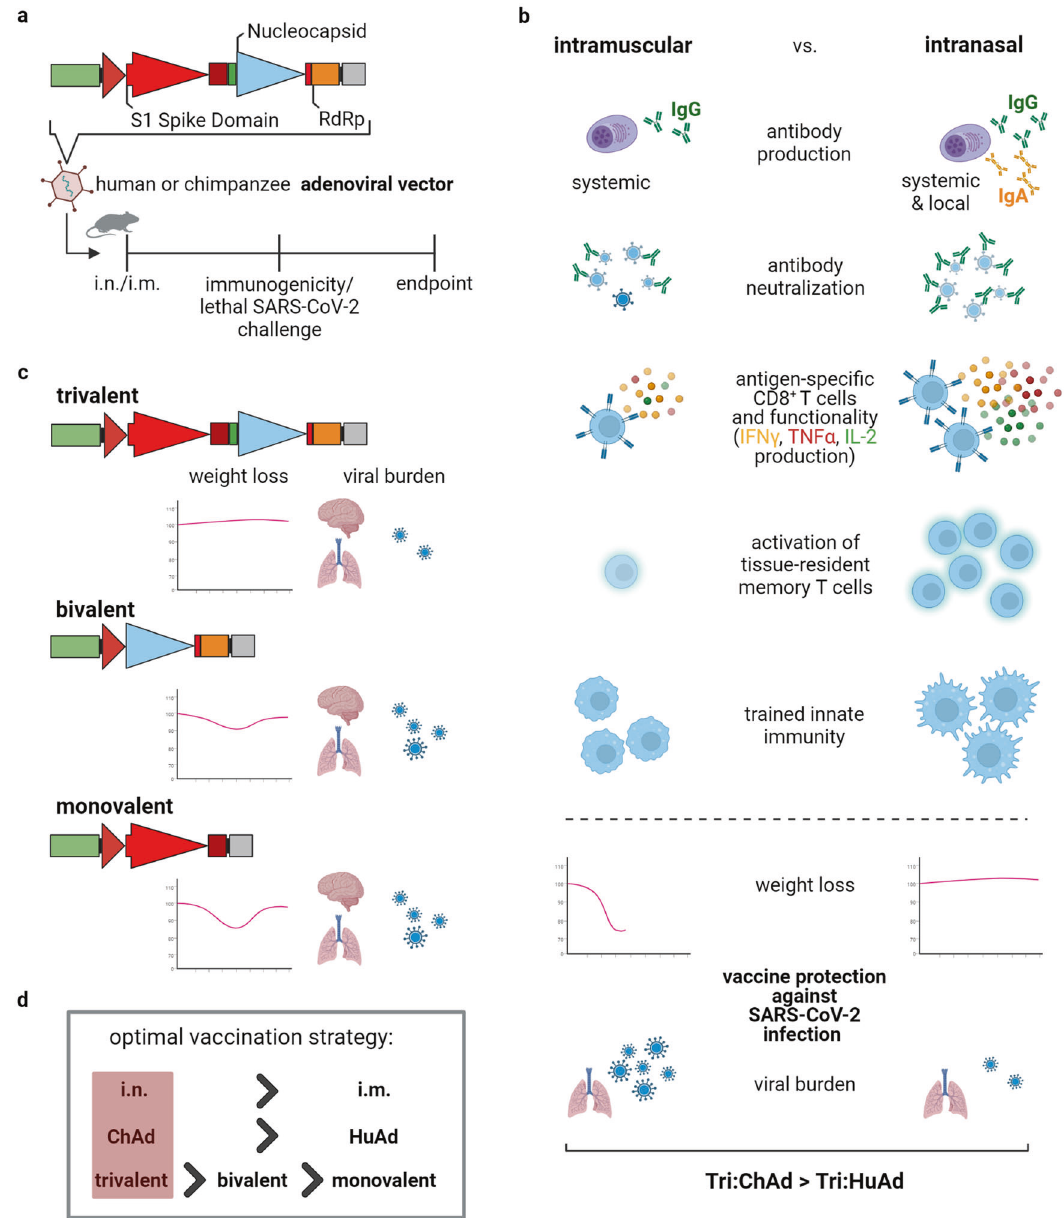
Fig. 1 Mucosal immunization with a trivalent ChAd-vectored vaccine induces superior protection against ancestral SARS-CoV-2 and variants of concern. a Three different SARS-CoV-2 antigen domains (S1 Spike Protein (S1), nucleocapsid (N), RNA-dependent RNA polymerase (RdRp)) were cloned into either human (Tri:HuAd) or chimpanzee (Tri:ChAd) adenoviral vectors. BALB/c mice were immunized either intranasal (i.n.) or intramuscular (i.m.) prior to lethal SARS-CoV-2 challenge. b Results of the comparative analyses utilizing both the two different vector platforms and routes of application (i.n. vs. i.m.). Mucosal immunization (i.n.) with the Tri:ChAd vaccine induced overall superior immune responses: increased production of systemic and local IgG and IgA antibodies, markedly enhanced antibody neutralization capacity, a strong induction of multifunctional CD8 + T cell responses as well as the strong activation of T RM and TII. I.n. vaccinated mice infected with an otherwise lethal dose of SARS-CoV-2 showed no body weight loss and a signi fi cant decrease of viral burden. c Schematic representation of the three different chimpanzee adenoviral constructs: the trivalent (S1, N, RdRp), bivalent (N, RdRp) and monovalent (S1) vaccines. Mucosal delivery of the trivalent vaccine exhibits highest protective ef fi cacy against SARS-CoV-2 and varianst of concern (VOC) indicated by prevention of morbidity (body weight loss) and a signi fi cant decrease in viral burden compared to mice that received the bivalent or monovalent vaccines. d The optimal vaccination strategy against both SARS-CoV-2 and VOC was proven to be an intranasal application of a trivalent vaccine using the chimpanzee adenoviral vector platform. Created with BioRender.com fi ndings that should be considered as blueprint for the develop- cell responses together conferring protection against an otherwise devastating SARS-CoV-2 infection. 1 Without any doubt, the ment of sophisticated next-generation vaccines. They identi fi ed mucosal delivery of a trivalent vaccine incorporated in a worldwide concerted effort that resulted in the incredibly fast chimpanzee-derived Ad-vector as the ideal tool for the stimulation development of fi rst-generation SARS-CoV-2 vaccines was a great of systemic and, even more important, mucosal antibody and T success in containing the global pandemics. However, since we